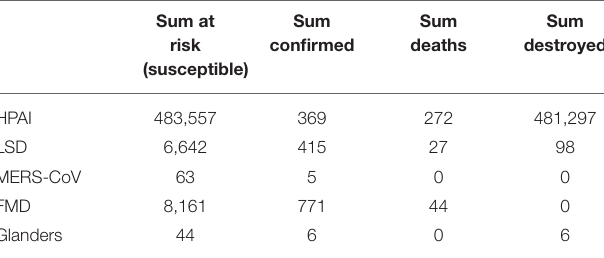
TABLE 2 | Summary statistics of all animal diseases in Kuwait